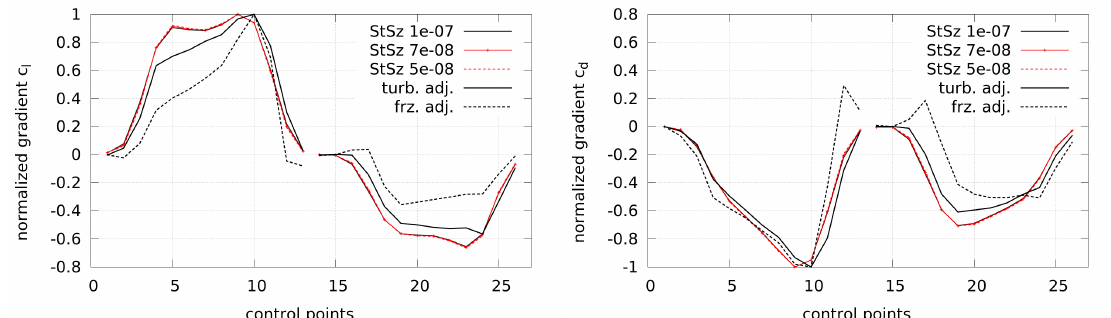
Figure 4. Comparisons of gradients obtained by finite differences (FsD) and gradients via the adjoint approach for lift objective (“gradient c l ”) and drag objective (“gradient c d ”). Different step sizes (StSz) are used for finite differencing. Adjoint and frozen turbulence are used for gradients via the adjoint approach (labeled as “adj. turb” and “frz. turb”,